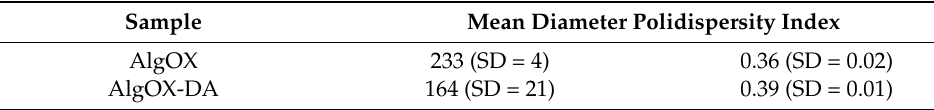
Table 2. Mean particle size of AlgOX and AlgOX-DA according to PCS analysis.